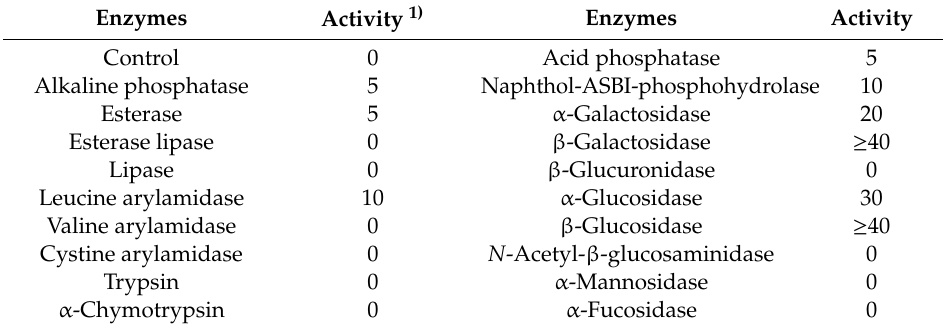
Table 1. Enzymatic activity of Leuconostoc mesenteroides KCCM 12010P using an API kit. Enzymes Activity 1) Enzymes Activity Control 0 Acid phosphatase 5 Alkaline phosphatase 5 Naphthol-ASBI-phosphohydrolase 10 Esterase 5 α -Galactosidase 20 Esterase lipase 0 β -Galactosidase ≥ 40 Lipase 0 β -Glucuronidase 0 Leucine arylamidase 10 α -Glucosidase 30 3 of 13 Valine arylamidase 0 β -Glucosidase ≥ 40 Cystine arylamidase 0 N -Acetyl- β -glucosaminidase Trypsin 0 Trypsin 0 α -Mannosidase 0